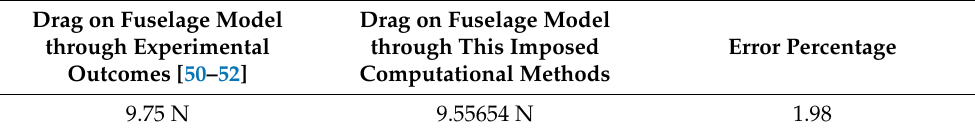
Table 12. Comprehensive outcomes of drag for both computational and experimental outcomes [50–52].